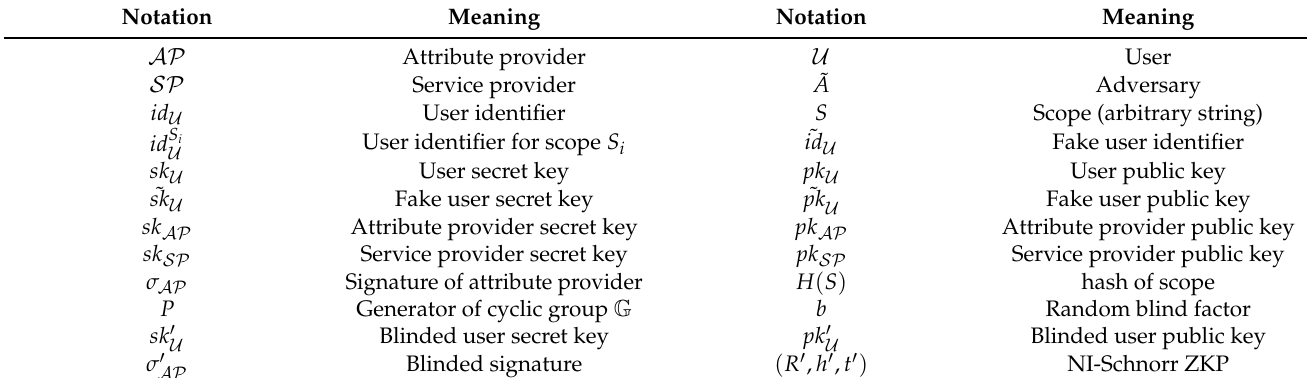
Figure 1. Overview of the information exchange between roles. ( 1 ) ing for a credential for a given scope S . In this case, this is carried out two times, one for scope AP S 1 and one for scope S 2 . ( 2 ) After user identity verification, This credential is only valid for S x within the request. ( 3 ) the credentials to . The figure illustrates four cases: ( 4a ) SP scope S 1 , verification succeeds and SP accepts the credential ( 4b ) SP of scope S 2 , verification fails and SP rejects the credential. ( 4c ) of scope S 1 , verification fails and SP rejects the credential. ( 4d ) scope S 2 , verification succeeds and SP accepts the credential. Table 1 presents a guide to the specific notation used. Table 1. Notation